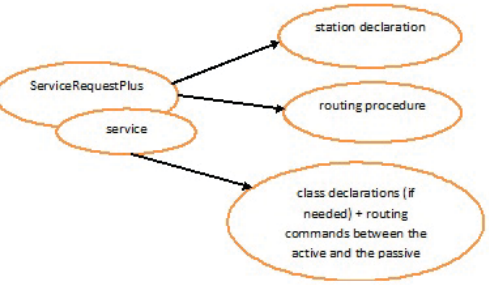
Figure 3: ServiceRequestPlus transformation steps